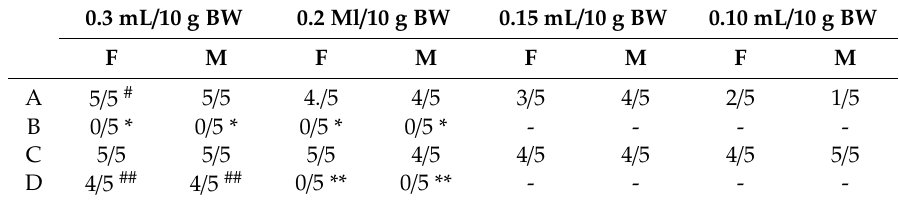
Table 4. Acute toxicity test results of samples A, B, C, and D in mice by oral